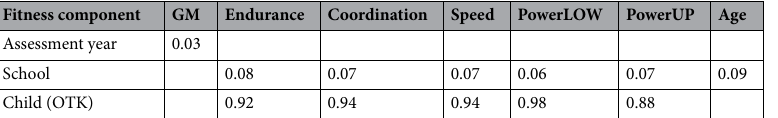
Table 3. Variance components for older-than-keyage (OTK) children. Endurance = cardiorespiratory endurance (i.e., 6 min run test), Coordination = star run test, Speed = 20-m linear sprint test, PowerLOW = lower limbs muscle power (i.e., standing long jump test), PowerUP = upper limbs muscle power (i.e., ball push test), OTK = older-than-keyage children. VC for Residual = 0.65.